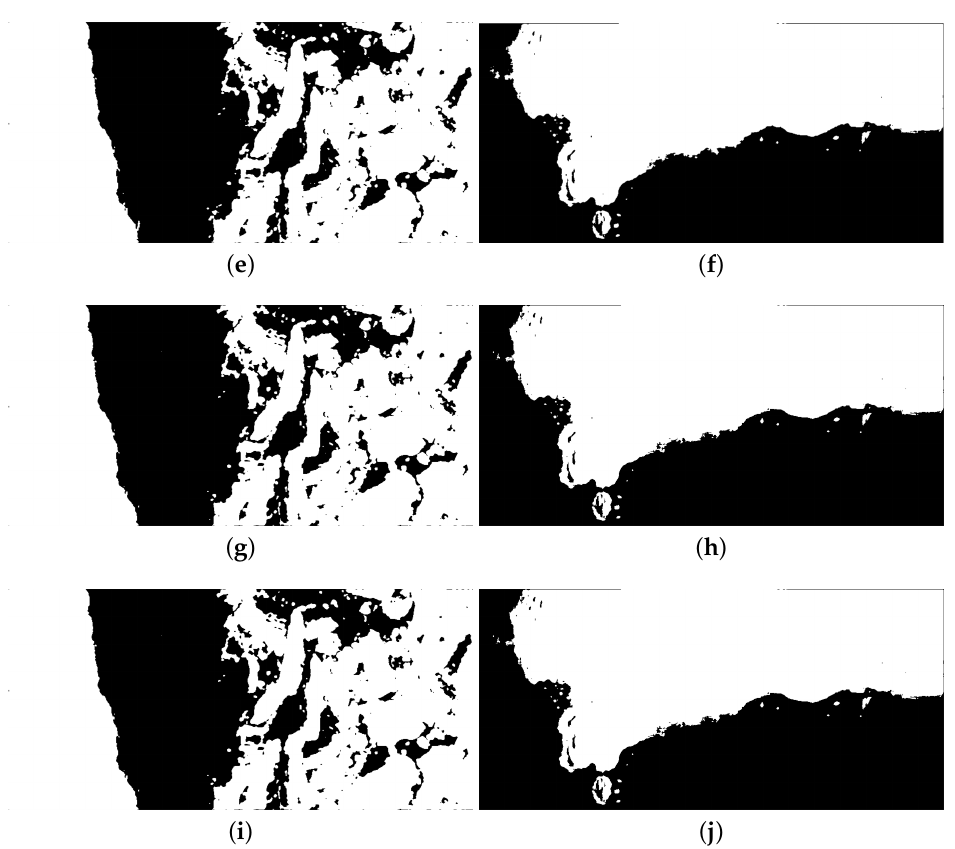
Figure 10. Original images and segmentation results: taken by the GeoEye-1 satellite. ( a ) Original image of ice sheet; ( b ) Original image of Santorin; ( c ) cpu_m segmentation of ice sheet; ( d ) cpu_m segmentation of Santorin; ( e ) cpu_c segmentation of ice sheet; ( f ) cpu_c segmentation of Santorin; ( g ) fpga_hls_ori segmentation of ice layer; ( h ) fpga_hls_ori segmentation of Santorin; ( i ) fpga_hls_opt